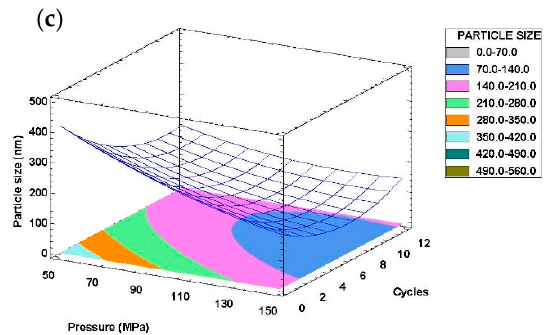
Figure 2. Response surface plots of interaction between emulsification input factors on particle size: ( a ) Rotor-stator mixer; ( b ) Ultrasonic homogenizer; ( c ) Microfluidizer processor.